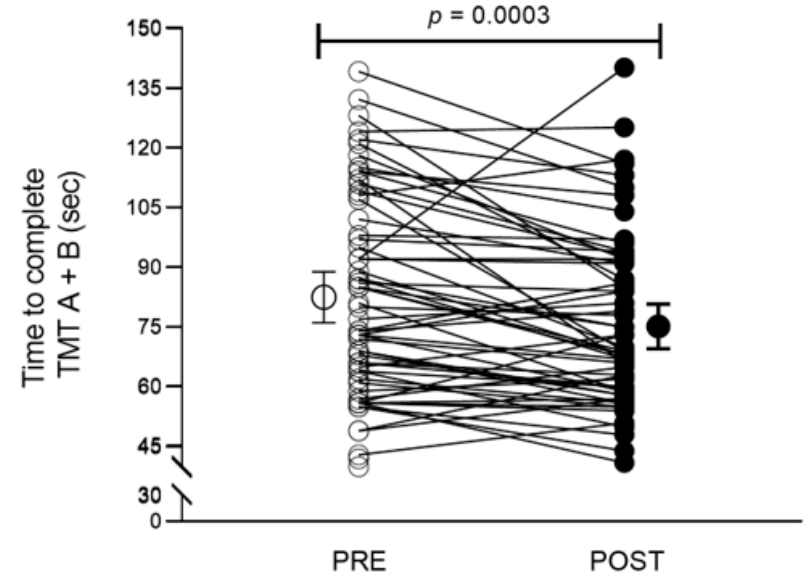
Figure 1. Participants completed the Trail Making Test A + B faster after an acute prolonged exercise session (n = 62; 21–70 years of age). Data analyzed via paired sample t -test. Table 2. Effect sizes for comparisons of time to complete cognitive task (pre vs. post-exercise).